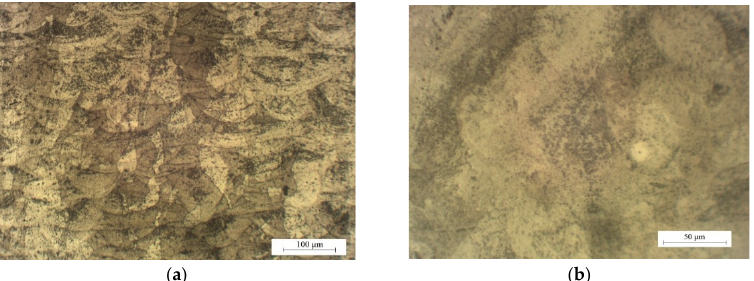
Figure 4. Microstructure of steel 12X18H10T manufactured by the LB-PBF: ( a ) cross-section perpen- dicular to the direction of laser scanning, ×200; ( b ) longitudinal cross-section parallel to the direction of laser scanning, ×500.